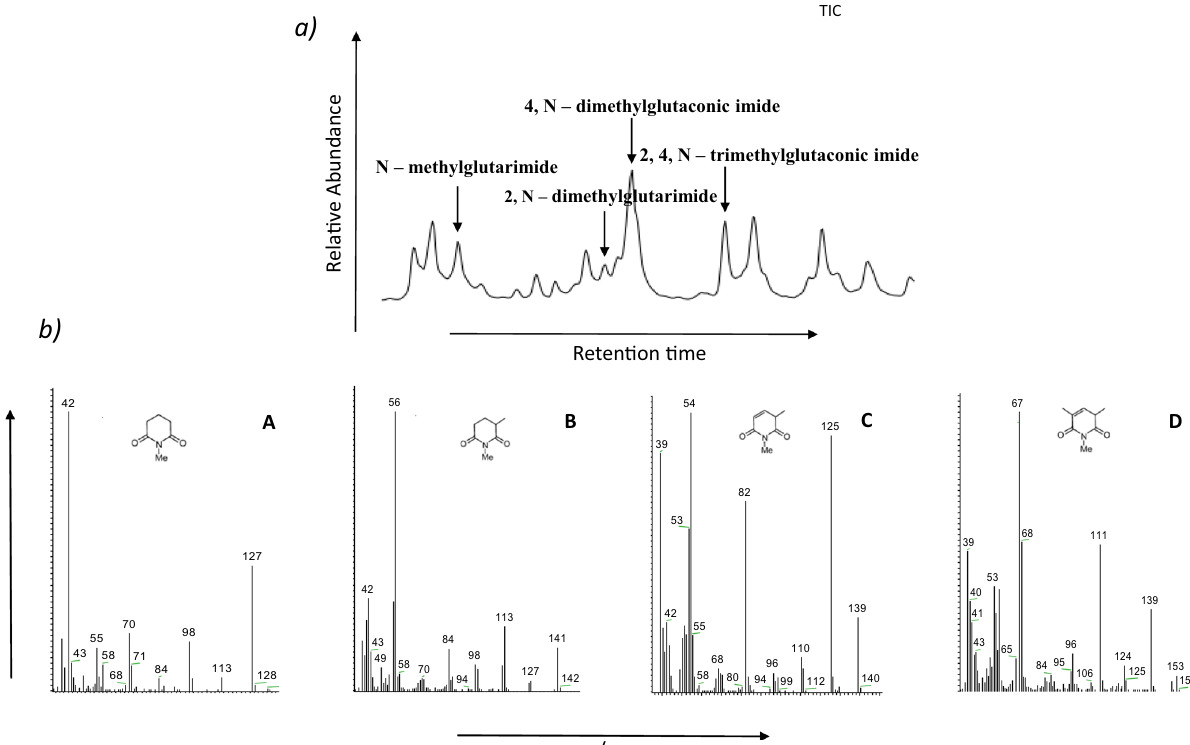
Fig. 2 a Total ion chromatogram obtained by applying TMAH-thermochemolysis on pure cPAA; b Mass spectra of the specific cPAA degra- dation products.